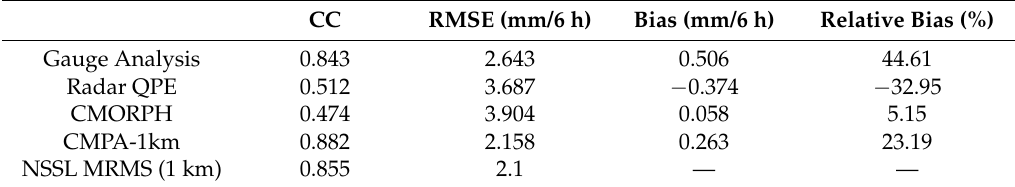
Table 5. Evaluation metrics of individual precipitation observations during the heavy rainfall event that occurred on 8–9 June 2015. NSSL, National Severe Storms Laboratory; MRMS, Multi-Radar/Multi-Sensor. CC RMSE (mm/6 h) Bias (mm/6 h) Relative Bias (%) Gauge Analysis 0.843